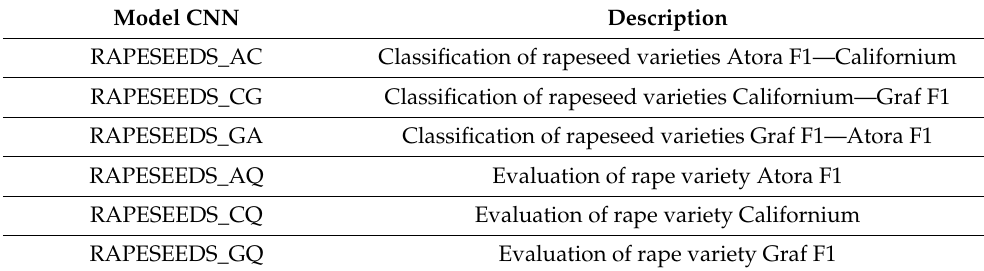
Figure 2. Visualization of images of rape seed samples. Table 2. Description of arboricultural seed classification